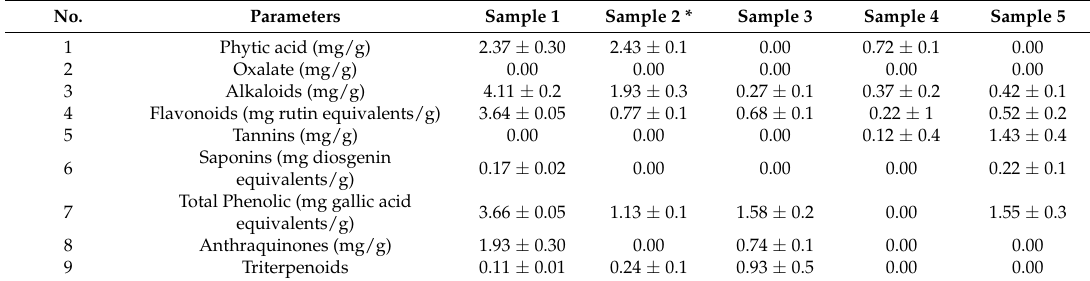
Table 2. Phytochemical quantitative analysis of alcoholic beverages flavoured with herbal